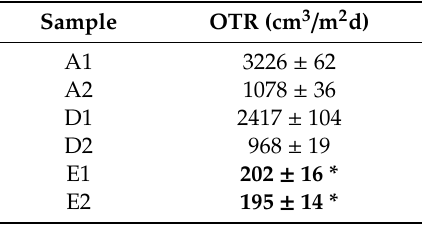
Table 7. The oxygen permeability between the reference foils and the foils with the application. Statistical significance is defined as * p < 0.05 compared to control sample (ANOVA